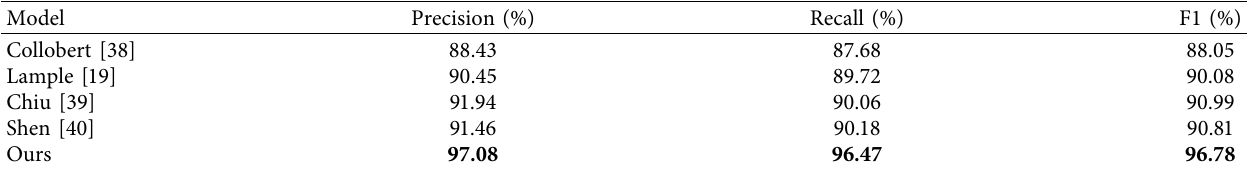
Table 5: . Experimental results of China People’s Daily.